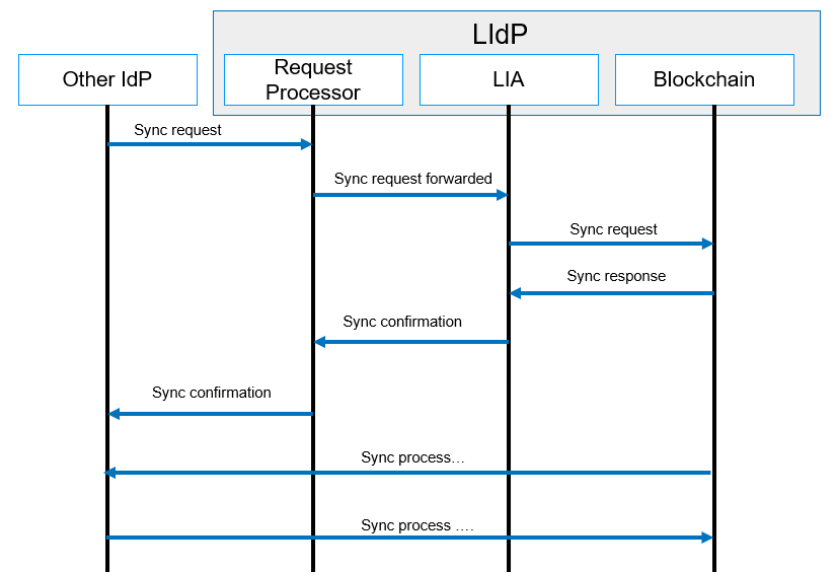
Figure 12. Synchronization process message flow.